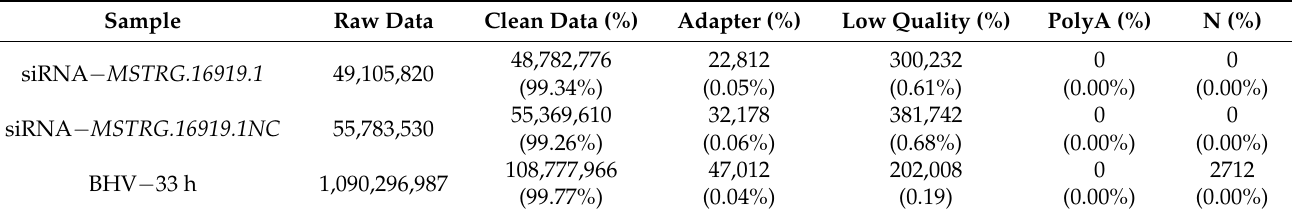
Table 2. Statistics of data